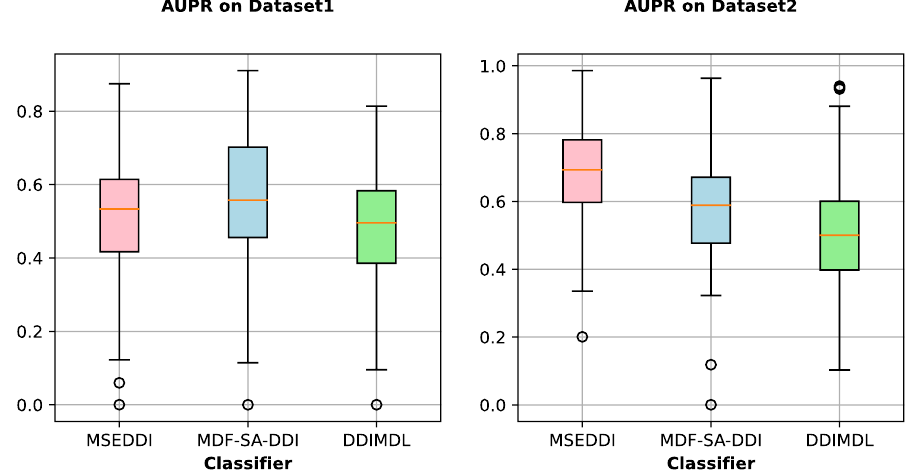
Figure 3. The statistic of AUPR for partial baselines in all events.